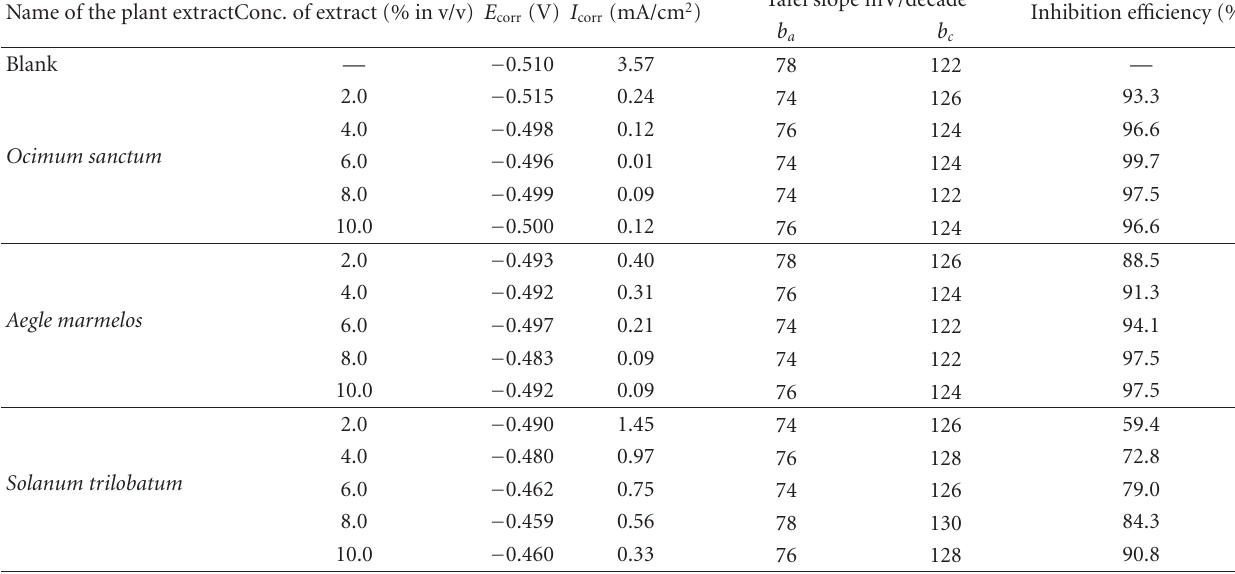
Table 3: Potentiodynamic polarization parameters for mild steel in 1N HCl containing various concentrations of the plant extracts.